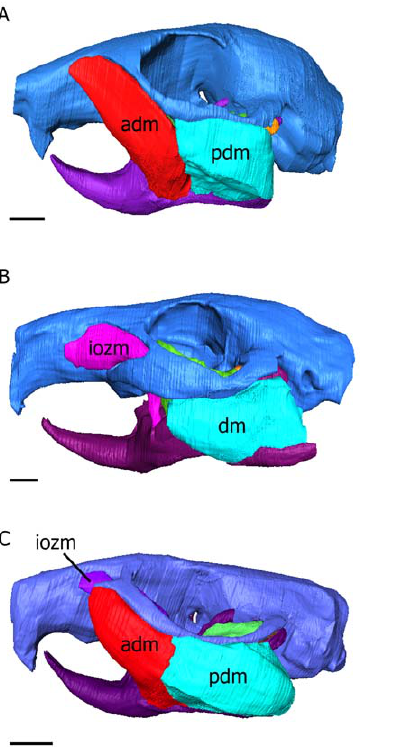
Figure 1. Three-dimensional reconstructions of the skull, mandible, deep masseter and zygomatico-mandibularis of three rodents. (A) sciuromorph (squirrel); (B) hystricomorph (guinea pig); (C) myomorph (rat). adm, anterior deep masseter; iozm, infraorbital part of the zygomatico-mandibularis; pdm, posterior deep masseter. Scale bars=5 mm.